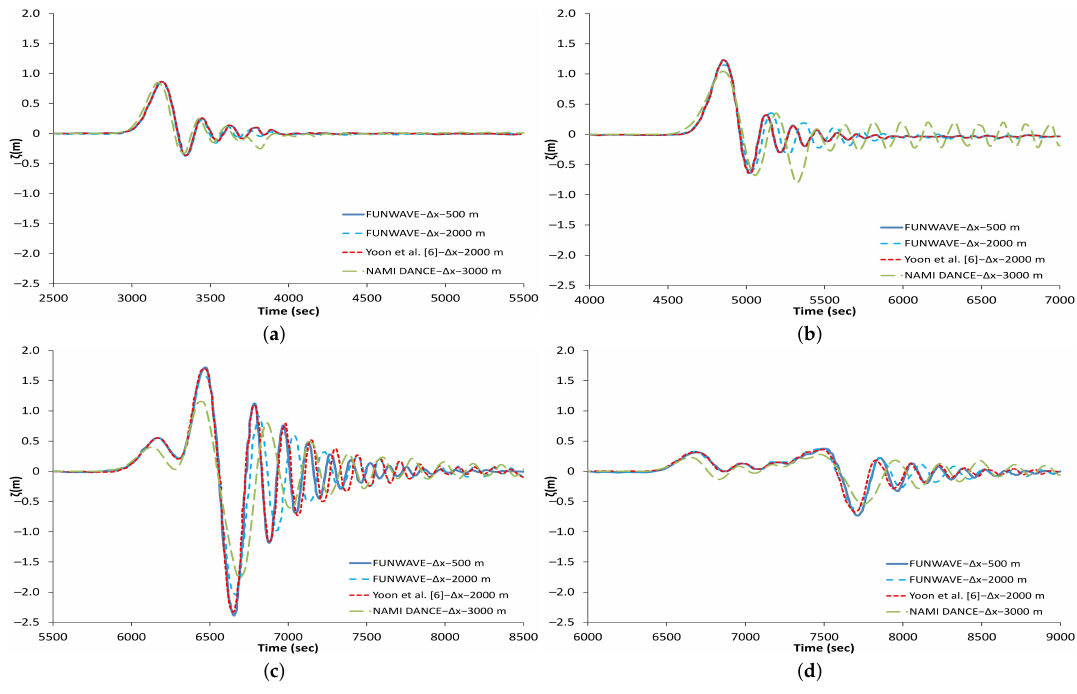
Figure 7. Comparison of time history of water surface profiles of NAMI DANCE, FUNWAVE (using Nwogu’s BTEs) [8,9] and Yoon et al.’s [6] solution at numerical gauges: ( a ) Gauge 1, ( b ) Gauge 2, ( c ) Gauge 3 and ( d ) Gauge